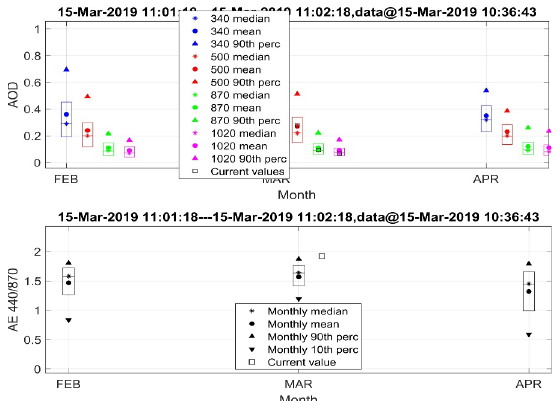
Fig. 1. AOD and AE (current values versus climatological monthly values).